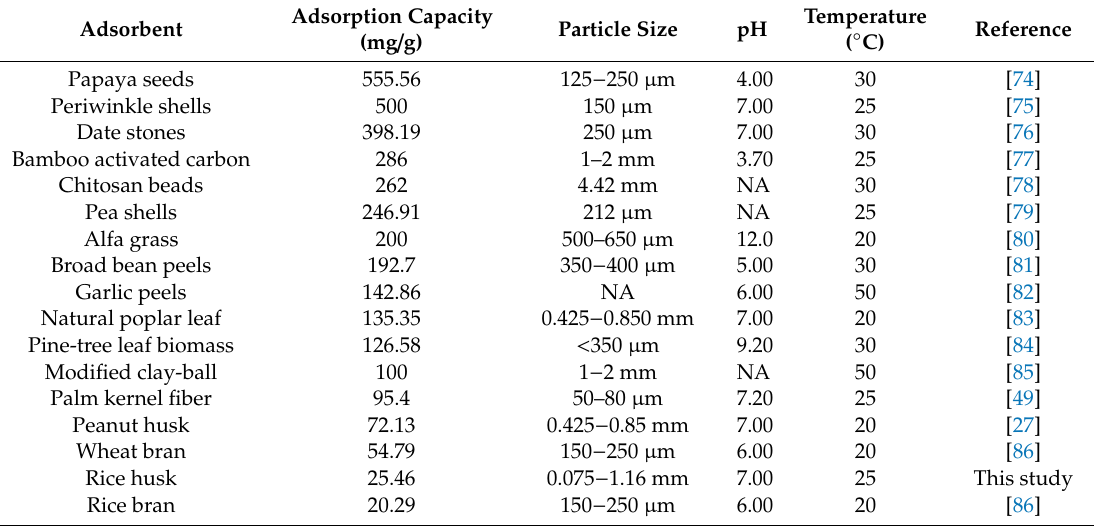
Table 3. Comparison of methylene blue adsorption capacity to that of various adsorbents.